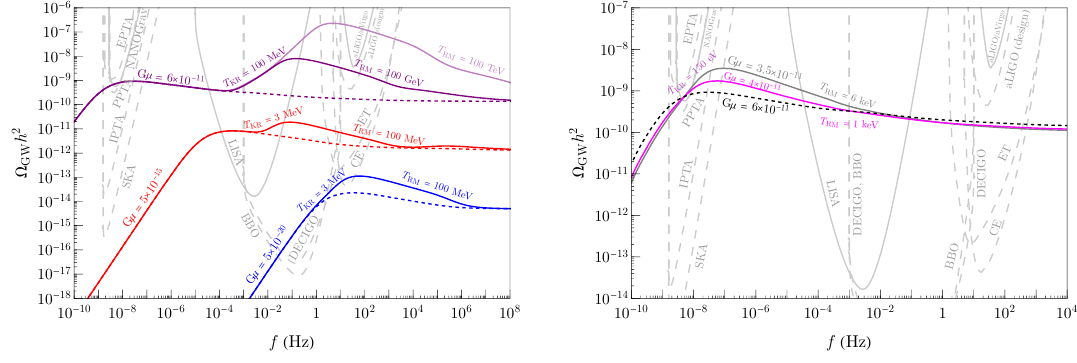
Figure 13 . Representative spectra of primordial gravitational waves emitted from local cosmic strings experiencing axion kination (solid) and the standard Λ CDM cosmology (dashed). Long eras of kination exhibit greater amplitudes in the triangular shaped peak of Ω GW h 2 , which is a key signature of axion kination. Of crucial importance is the slowly decaying high frequency tail arising from the sum over high mode numbers which enables detectors like BBO, DECIGO, and CE to detect deviations from the Λ CDM spectrum even when the kination peak is not located within their frequency domain. Left: early axion kination cosmology where kination occurs before BBN. The top most contour shows the gravitational wave amplitude when Gµ is fixed to pass through the NANOGrav signal. Right: late axion kination cosmology where kination occurs in the epoch between CMB and BBN. For each contour, we plot the required Gµ to pass through the NANOGrav